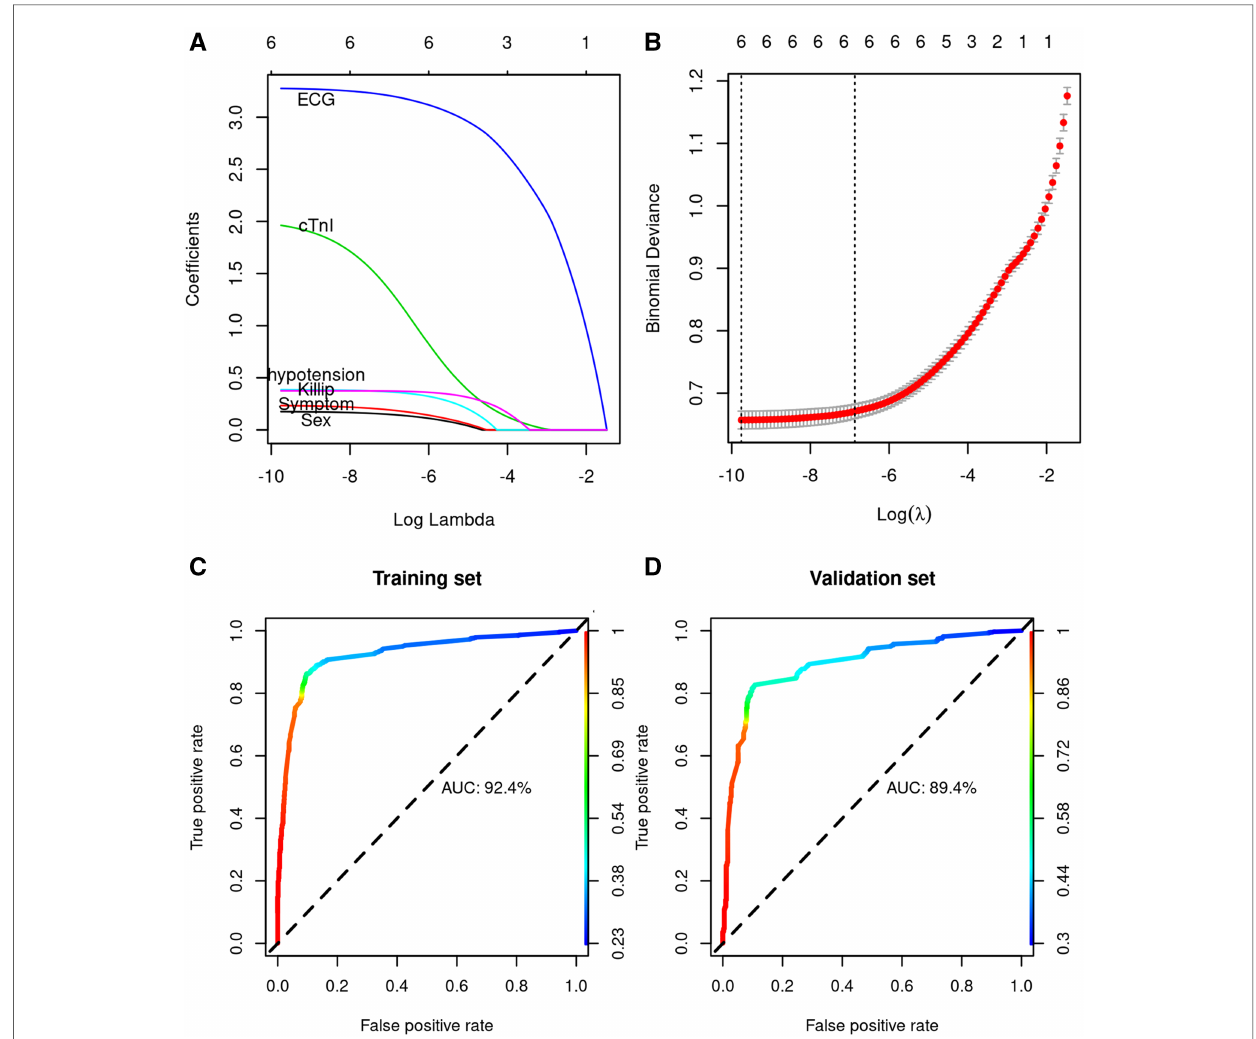
FIGURE 3 LASSO model pro fi le plots. ( A ) LASSO coef fi cient pro fi les of the 6 variables showing how the size of the coef fi cients associated with increasing value of the lambda penalty; ( B ) penalty plot for the LASSO model; color error bars indicate the standard error; ( C ) ROC curve of the prediction model for AMI diagnosis in the training cohort; ( D ) ROC curve of the prediction model for AMI diagnosis in the validation